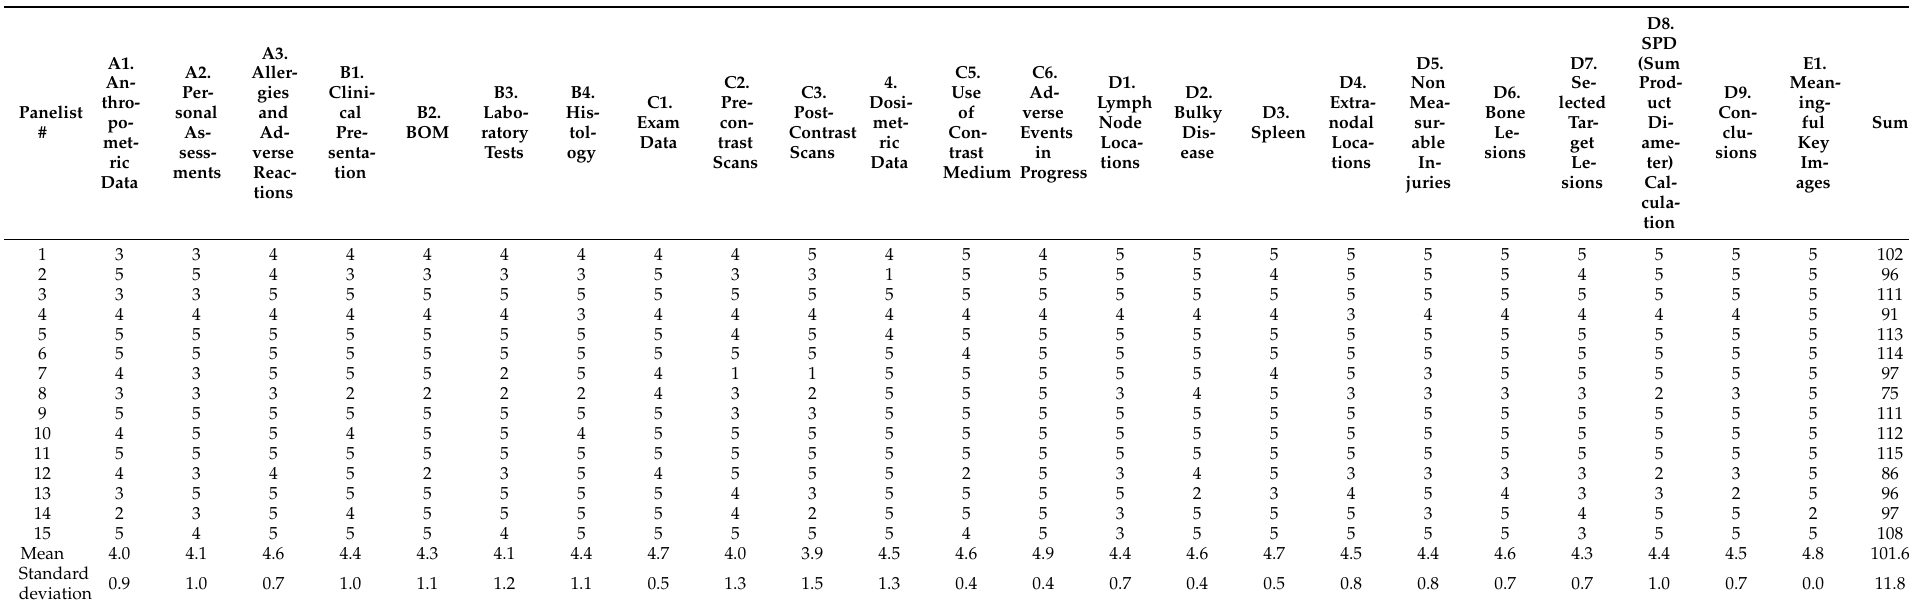
Table 1. Single scores and sum of scores of 15 panelists for structured report in the first Delphi